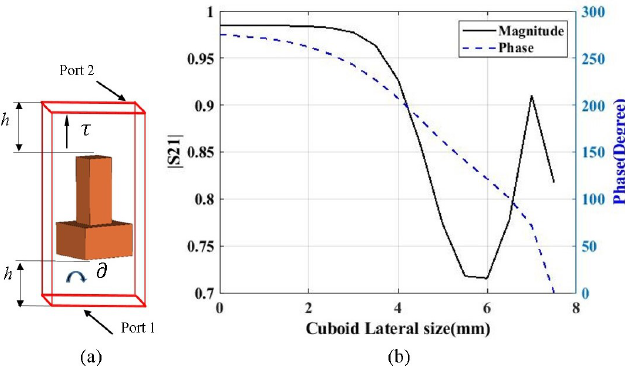
Figure 1. ( a ) Unit cell with two-port networks. ( b ) Generated transmission magnitude and phase plots.